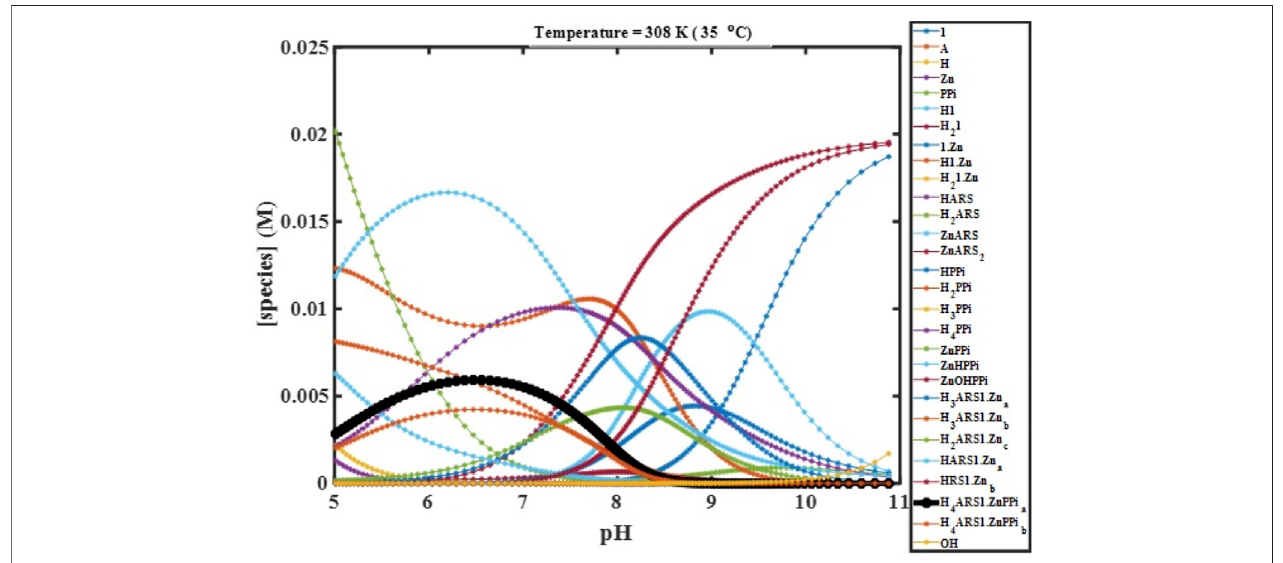
FIGURE4| Concentrationpro fi lesofallspeciesinthereactionmechanism( Scheme1 )atdifferentpHsobtainedusingthedevelopedmodelandNewton-Raphson Algorithm.